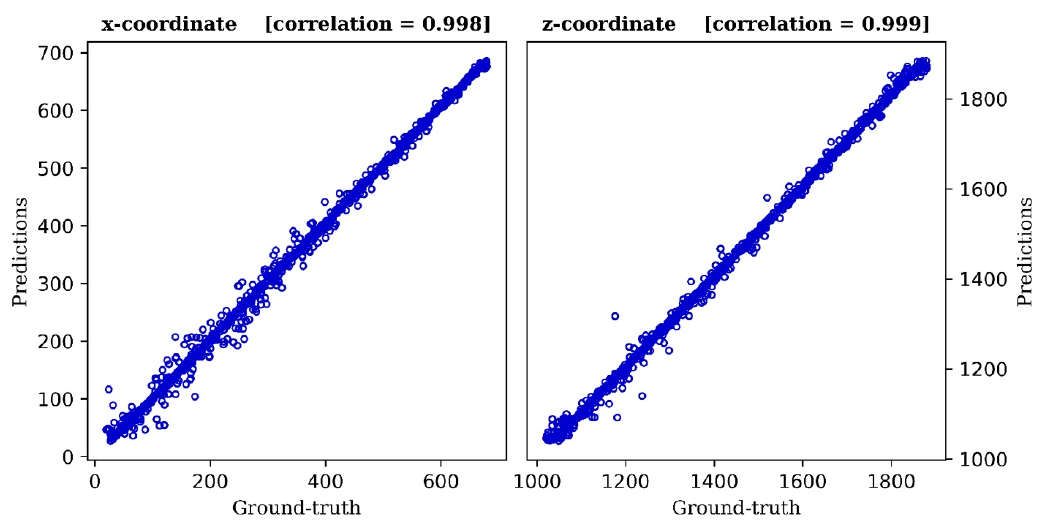
Figure 10. The correlation plot of the predicted versus ground-truth microseismic events after the exclusion of noise samples from the test dataset.